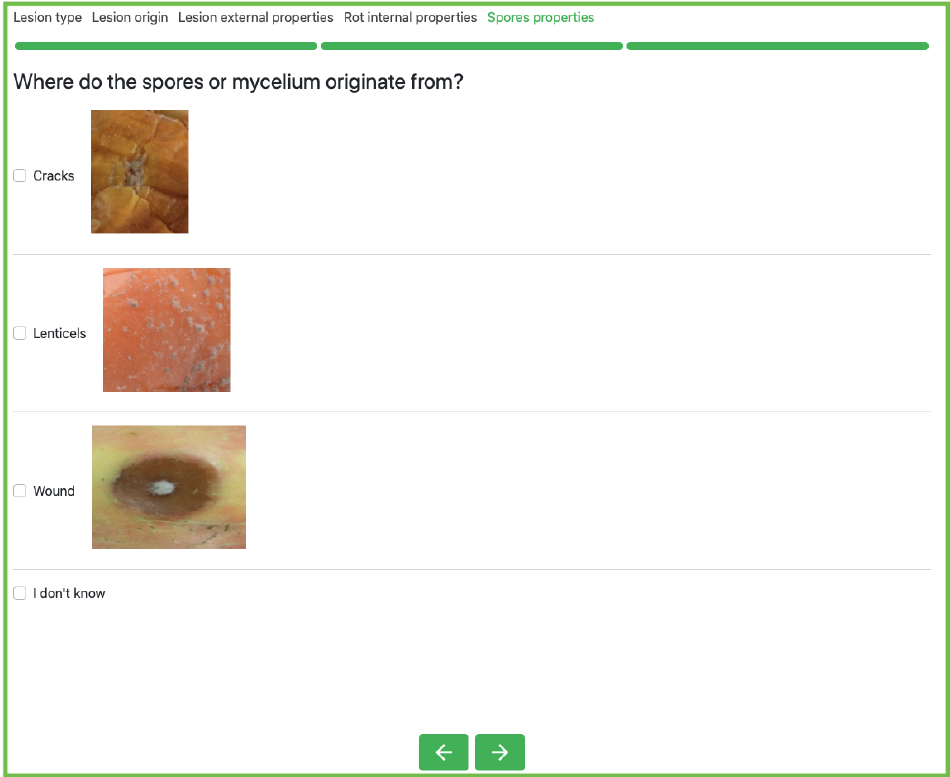
Figure 1. A round of feedback collection of BN-DSSApple , where the application asks about the origin of fungal